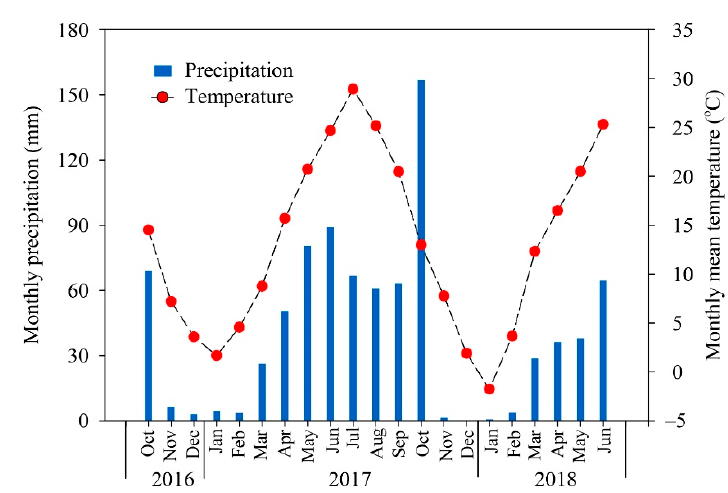
Figure 1. The monthly precipitation and mean temperature during wheat growing seasons in 2016– 2018.